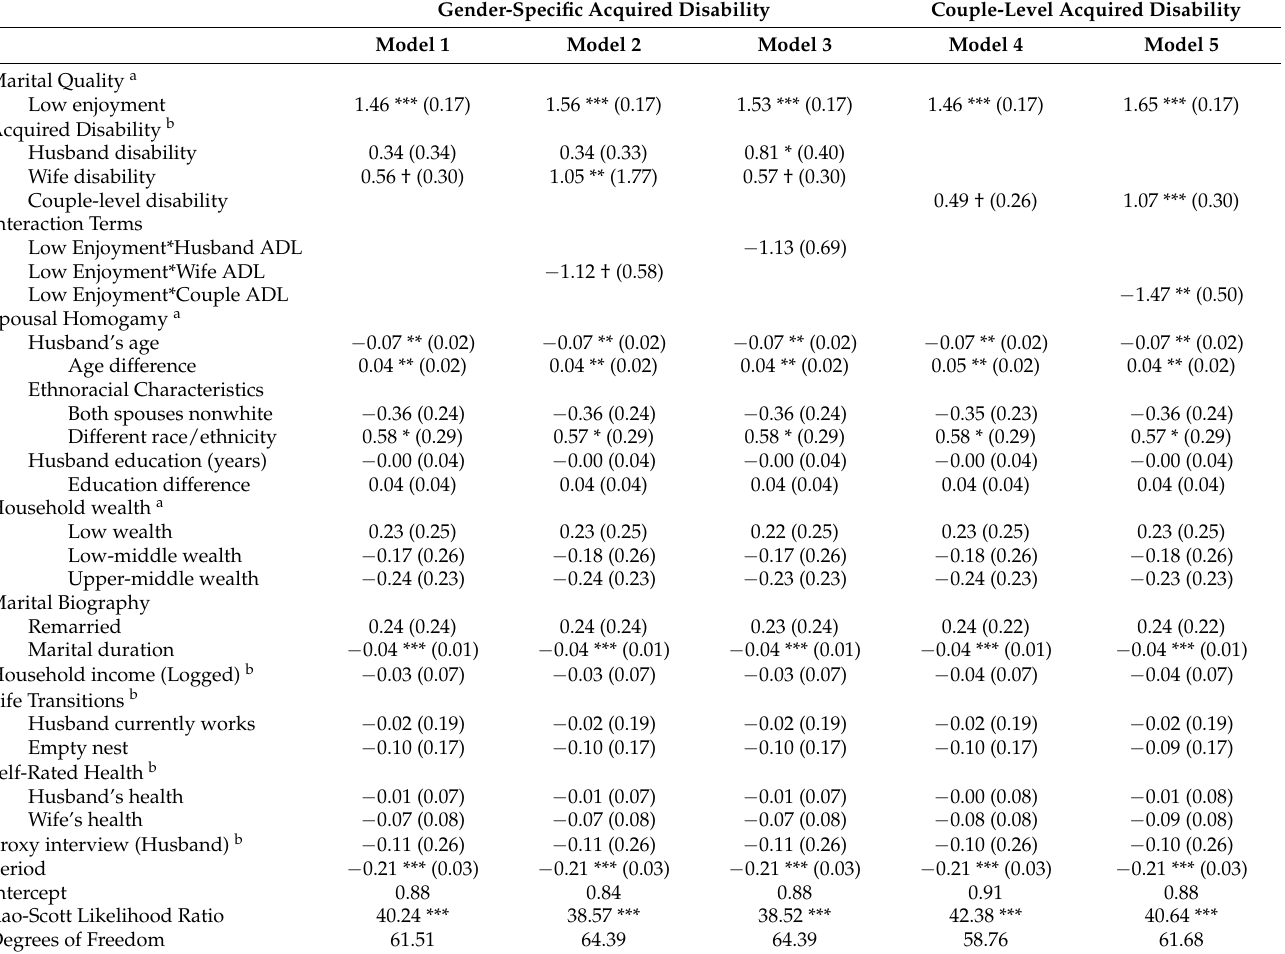
Table 3. Estimated Log Odds Coefficients (and Standard Errors) of Divorce from Multinomial Logistic